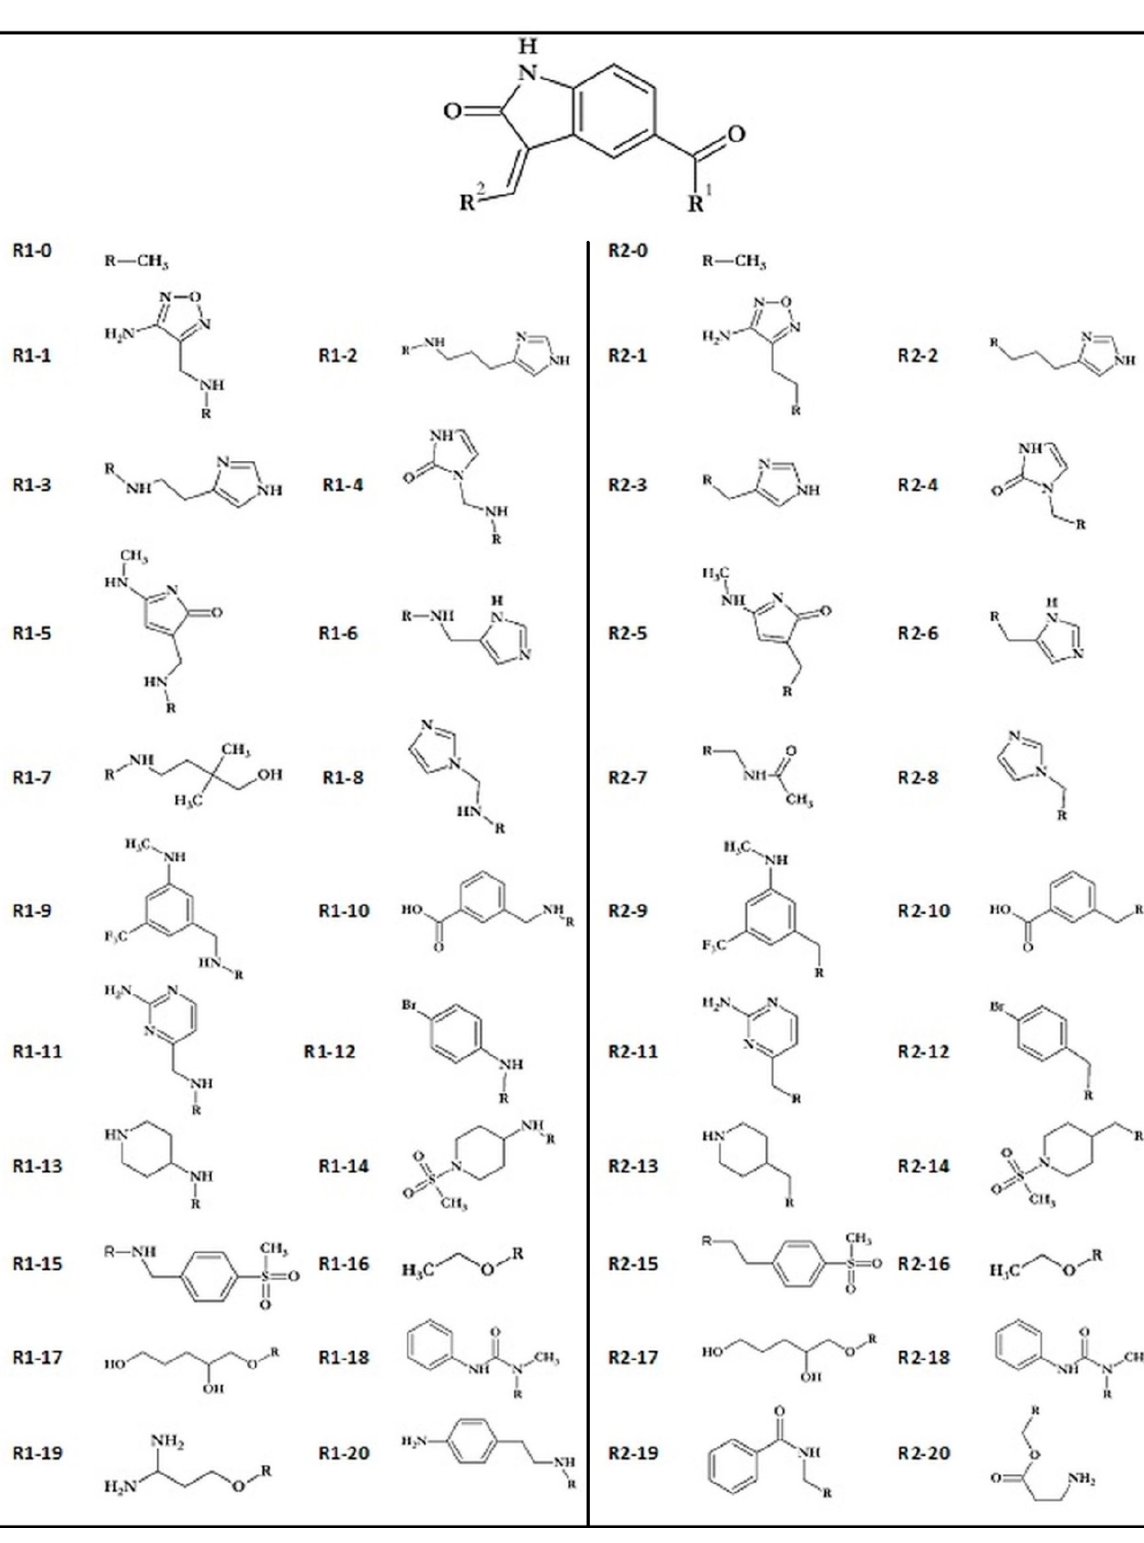
Figure 2. Oxindole core and functional groups used during creation of ligands.